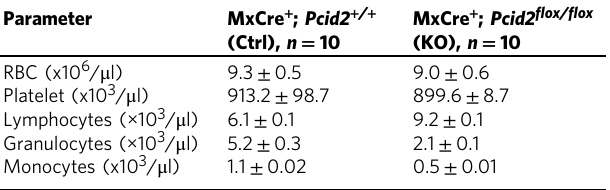
Table 1 Haematopoietic parameters